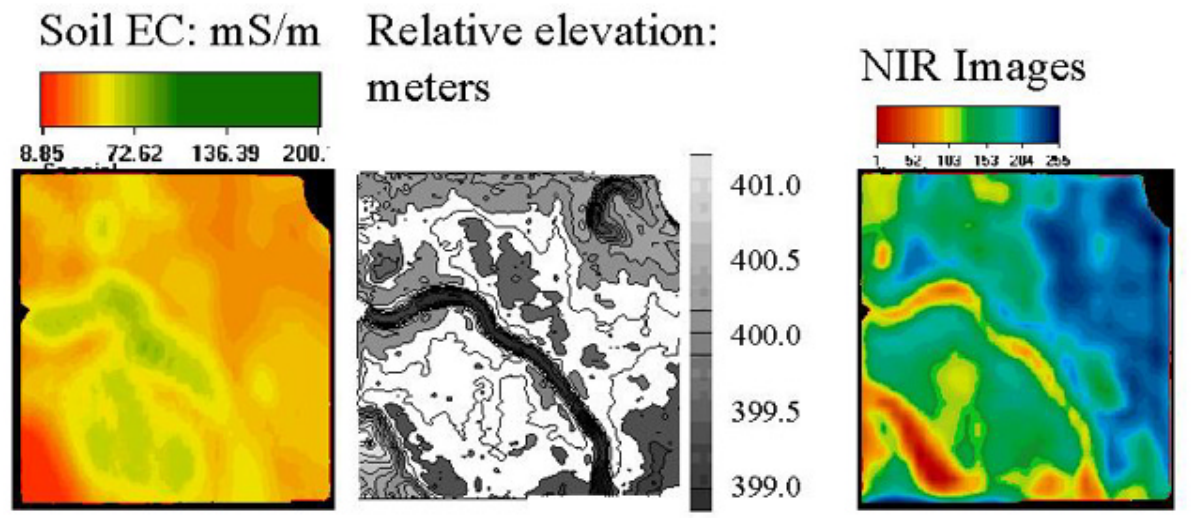
FIGURE 7. Soil EC, topography, and crop imagery from a 65-ha